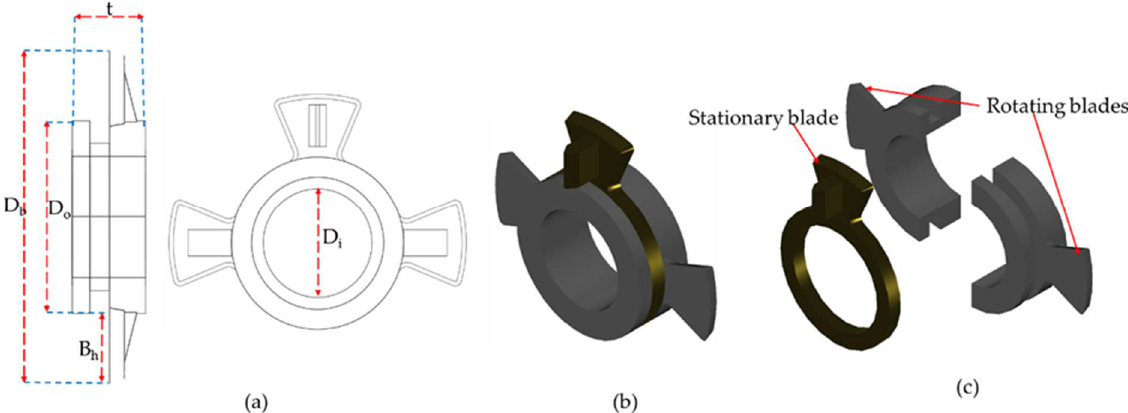
Figure 2. Actual propeller with rope cutter installed ( a ): actual geometry of the rope cutter ( b ); 3D model of the propeller without rope cutter ( c ); and with rope cutter ( d ).